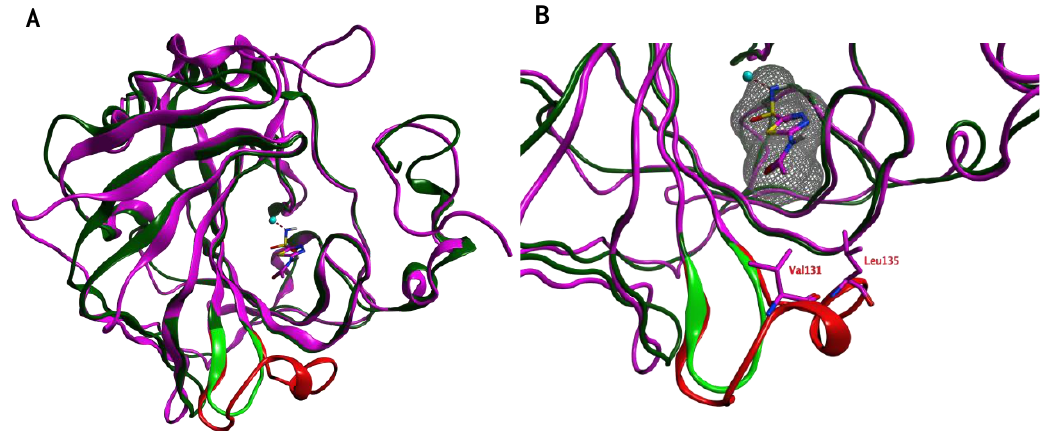
Figure 1. ( A ) The overlay of the hCA IX (purple and red) and PpCA (dark and light green) structures. The carbonic anhydrase enzymes (CA) inhibitor acetazolamide (purple) that is cocrystallized in the hCA IX structure is shown. ( B ) A zoom-in of the active sites of both enzymes reveals that the hCA IX loop (Ser124–Gly140; red) is larger compared to the PcCA loop (green) and approaches the cocrystallized ligand. The ligand surface is indicated in a grey mesh.